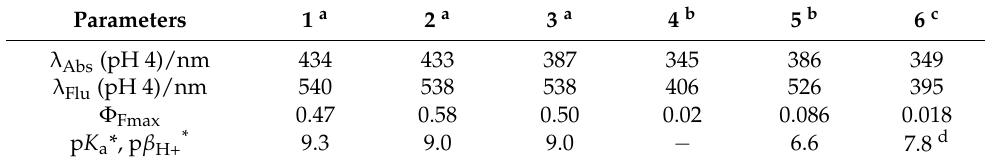
Table 1. Photophysical data 1–6 from reported literature sources in solution [24–27]. Parameters